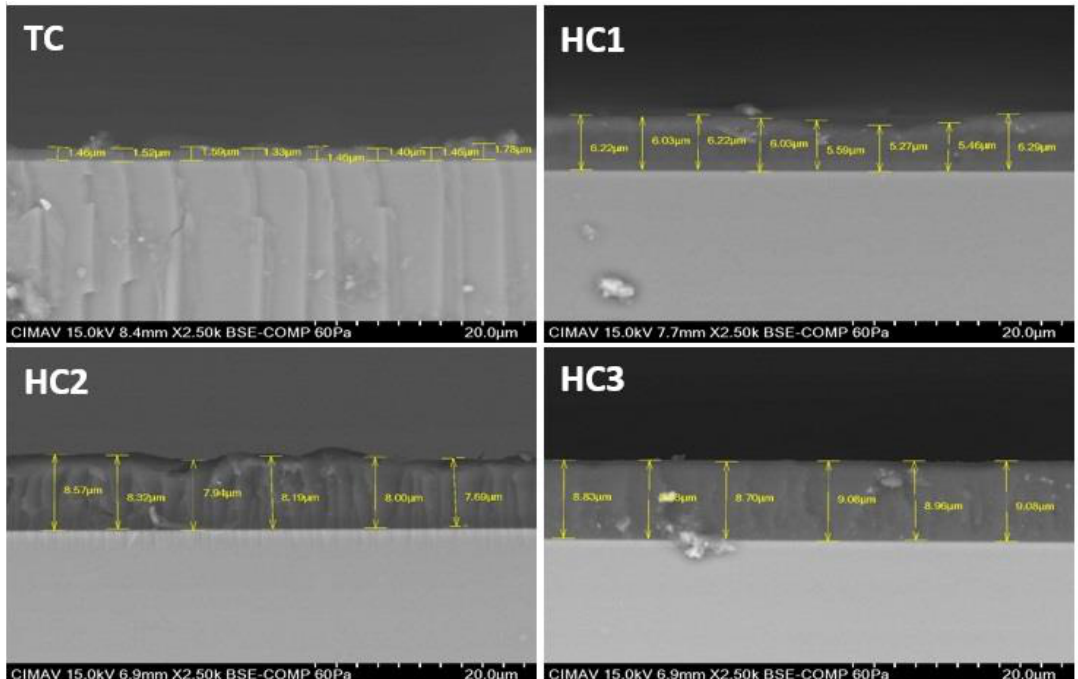
Figure 4. Four SEM micrographs of the cross sections of the coatings with several thickness. Measurements correspond to TC, HC1, HC2, and HC3.